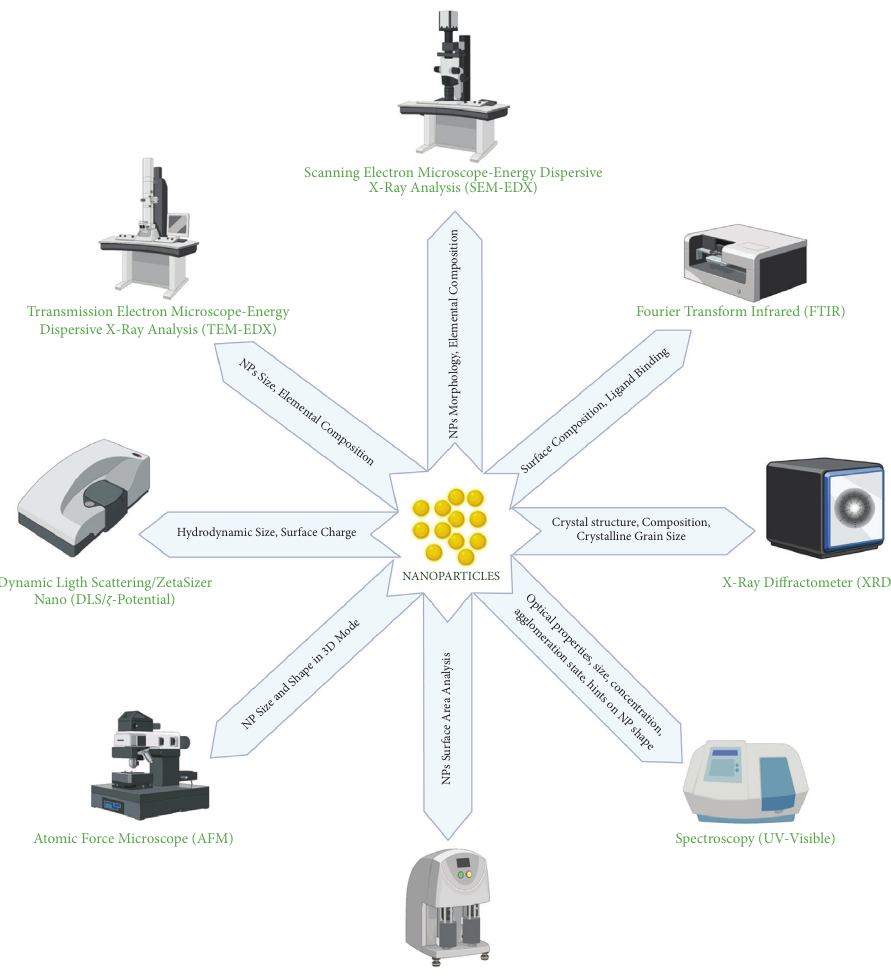
Figure 8: Summarization of popular methods for characterization of NPs. Created with BioRender.com with publication